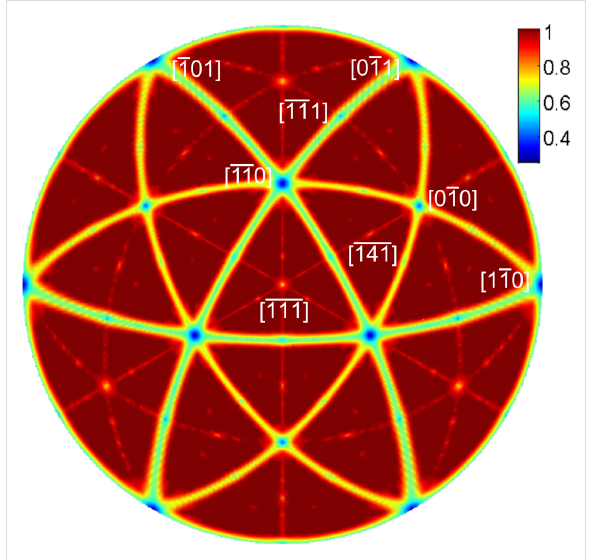
Figure 5: Calculated map of channeling directions for an fcc crystal. The lines connecting the nodes at low-index directions in the polar plot represent channeling directions in the used thin slab of an fcc crystal. The color coding (opaque fraction) allows a qualitative interpretation of the width and depth of the scattering minima.